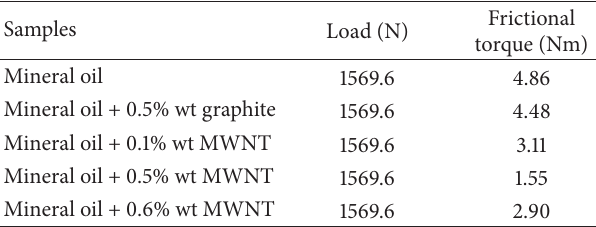
Figure 4: Scar diameter for different samples.